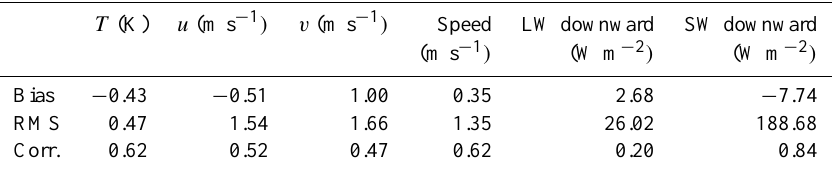
Table 1. Statistical comparisons between the COAMPS forecasts and the WHOI buoy observations. Correlation coefficients in the last row do not have any units.